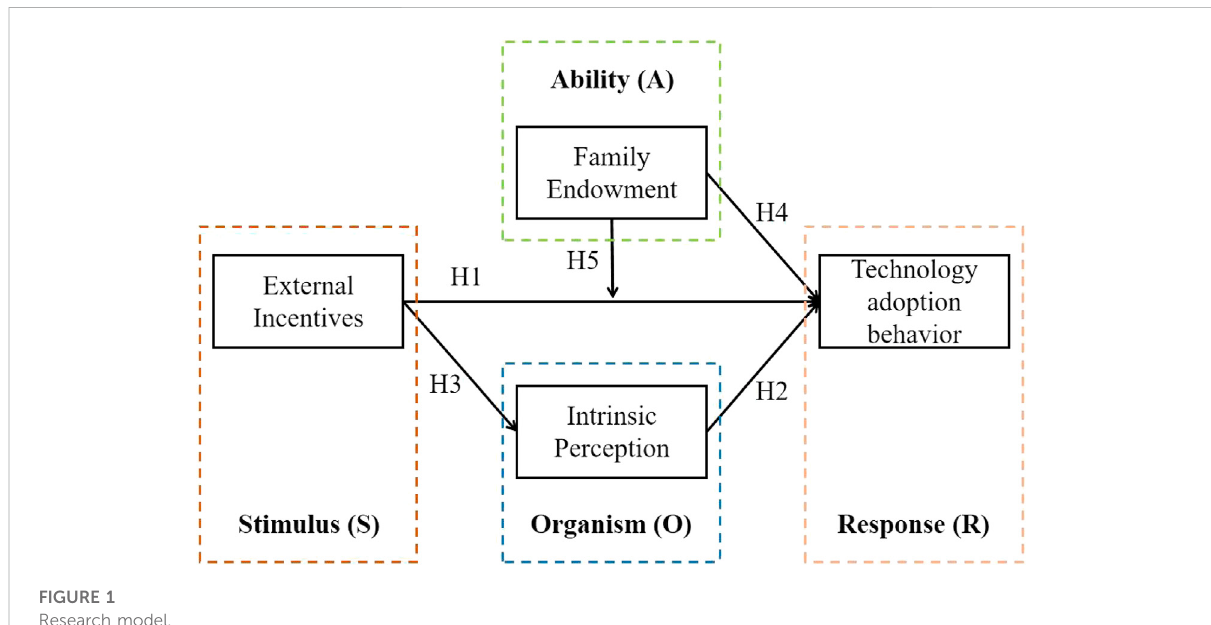
FIGURE 1 Research